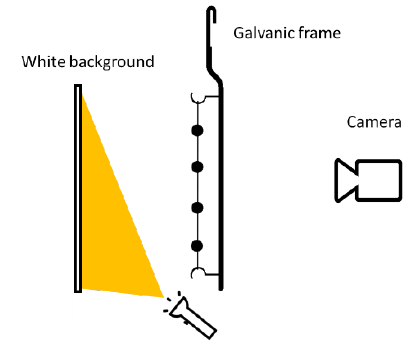
Figure 9. Lighted background setup.